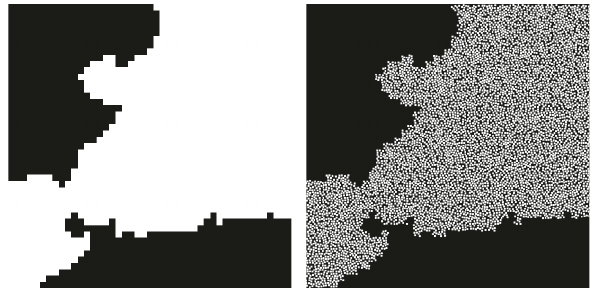
Figure 6: Plant positions generated from the vegetated tile map using the PDD with Wang tiling